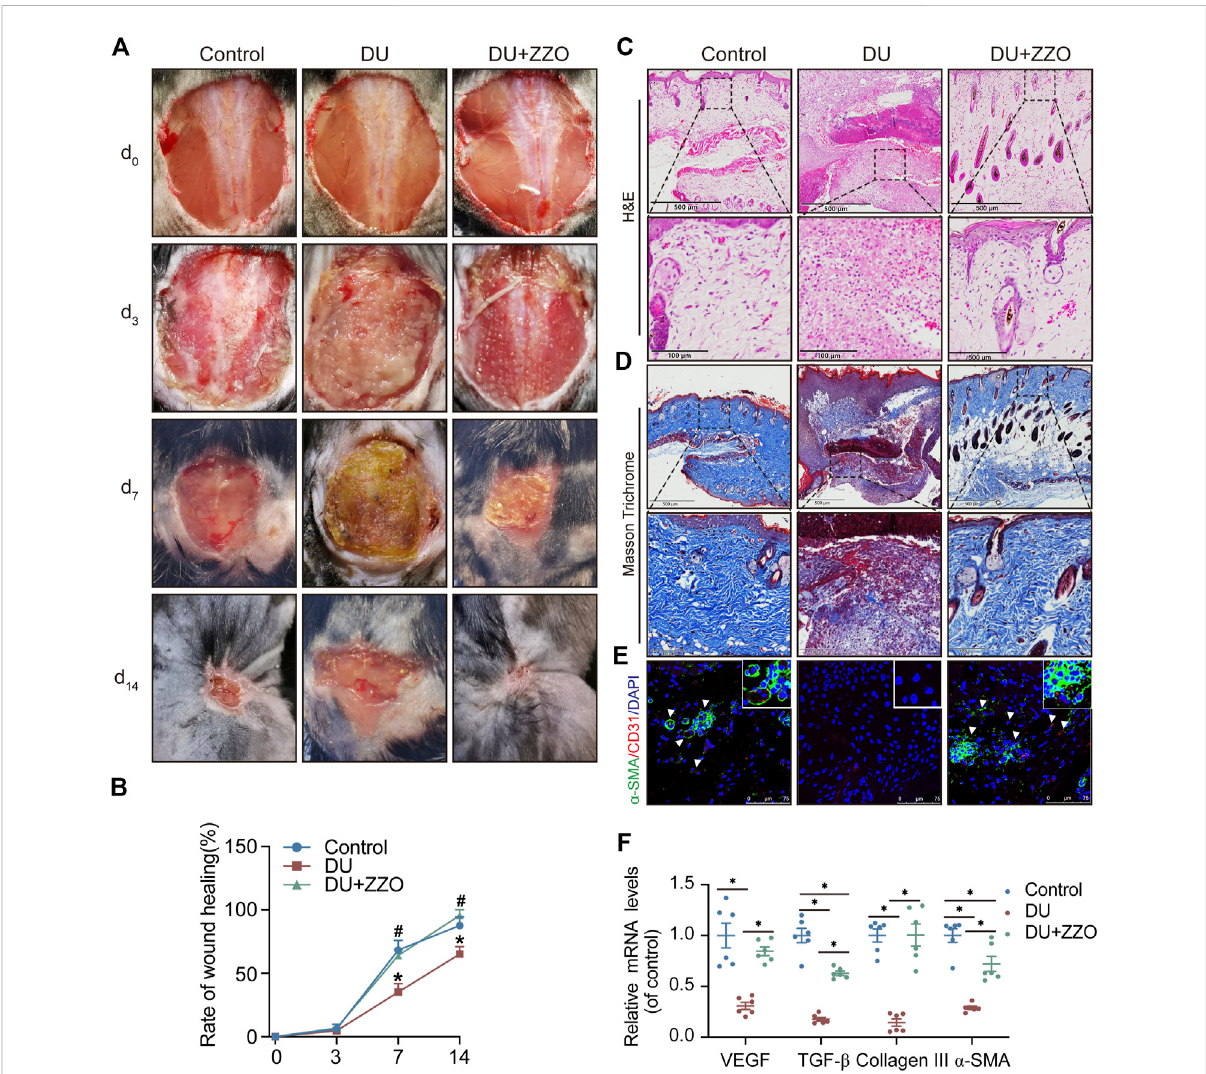
FIGURE 7 Ef fi cacy of ZZO anti-DU in vivo . (A,B) Optical picturesand related quanti fi cation of the wound closure rate in the Control group, DU group, and DU + ZZO group at days 0, 3, 7, and 14 after the skin operation ( n = 3, * p < 0.05, compared with the control group at the same time point, # p < 0.05, comparedwiththeDUgroupatthesametimepoint). (C) H&EstainingimagesofwoundtissuesintheControlgroup,DUgroup,andDU+ZZOgroup at day 14 ( n = 3 scale bar = 500 μ m for 10× and 100 μ m for 40×). (D) Masson ’ s trichrome staining at day 14 post-operation ( n = 3, scale bar = 500 μ m for 10× and 100 μ m for 40×). (E) IF expression of α -SMA and CD31 in wound healing areas ( n = 3, Scale bar = 75 μ m). (F) Relative